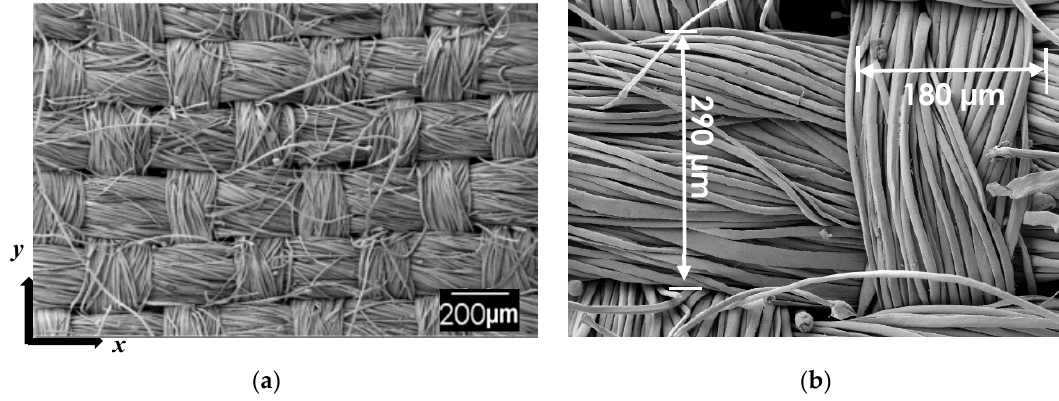
Figure 3. Sample SEM images of the microstructure of silk fabric, showing ( a ) an SEM image of multiple yarns (50×) and ( b ) higher magnification SEM image of two orthogonal yarns (200×).